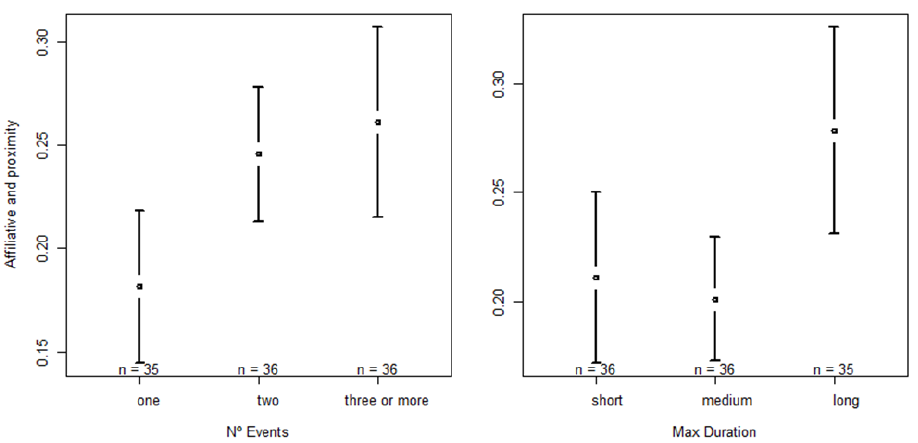
Figure 5. Confidence interval plots of social proximity and affiliative behaviors and the fixed effects number of sound events at night (N° events) and duration of the longest event (max duration).